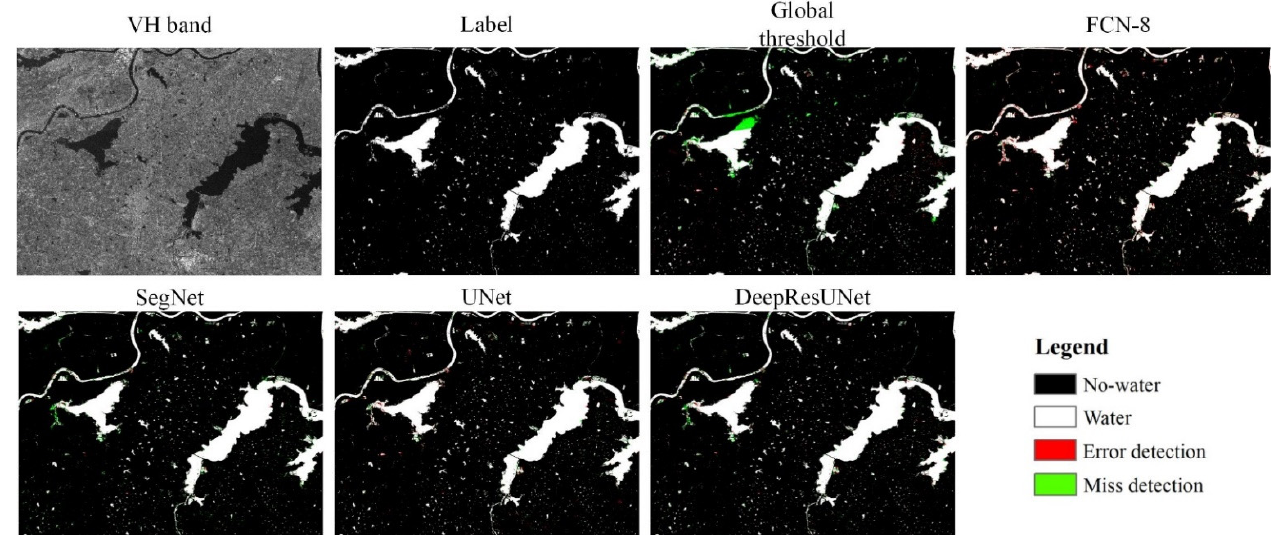
Figure 7. Flood mapping results of 5812 × 4260 images derived with different deep learning models with test dataset 1. Table 4. Band comparison experiments on UNet with two different test datasets. The first line presents the model performances with test dataset 1, and the second with test dataset 2. The values in bold indicate the highest numbers for corresponding